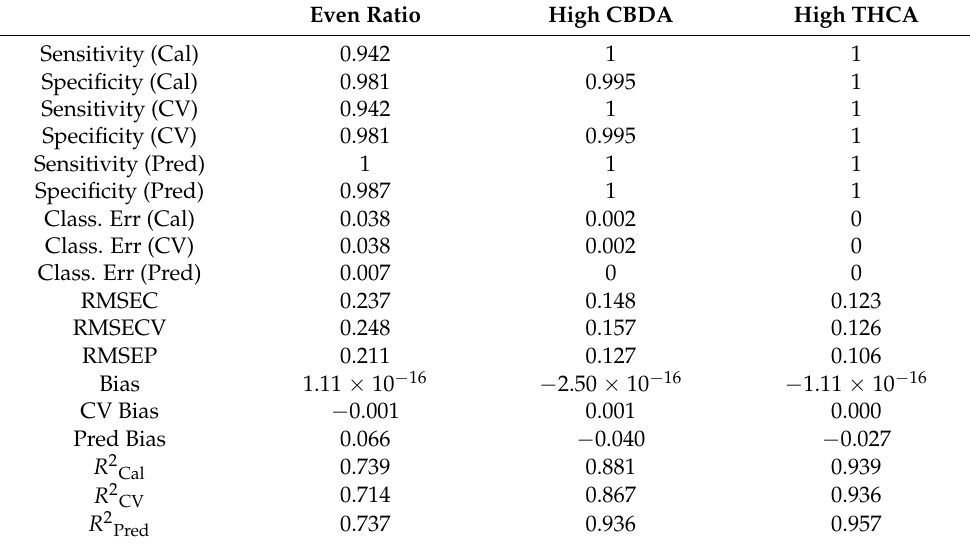
Table 1. Calibration and validation values of partial least square discriminant analysis (PLS-DA) models on the ratio of cannabinoid compounds analysed by the Bruker MPA II